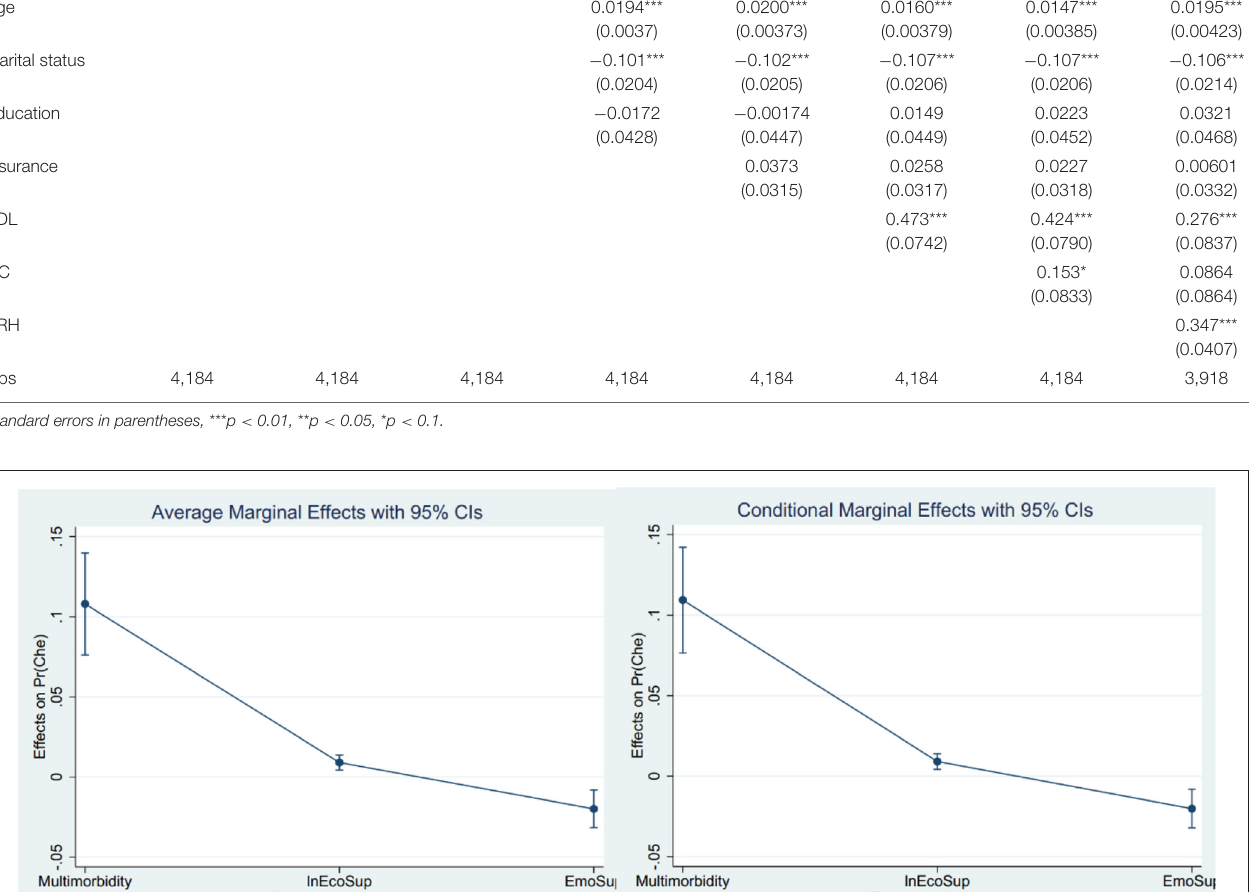
more emotionally connected children are, the less likely